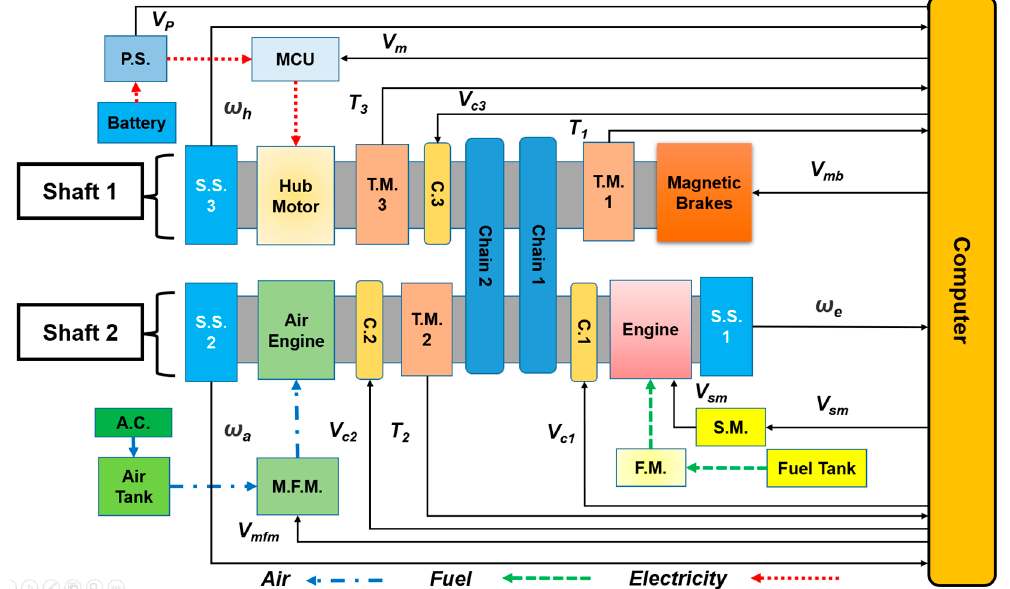
Figure 1. System components of the three-power-source hybrid platform.